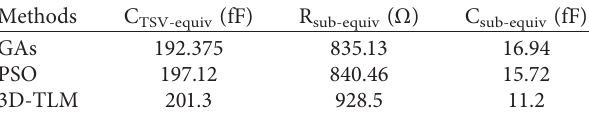
Table 2: TSV-TSV noise coupling parameters using GA and